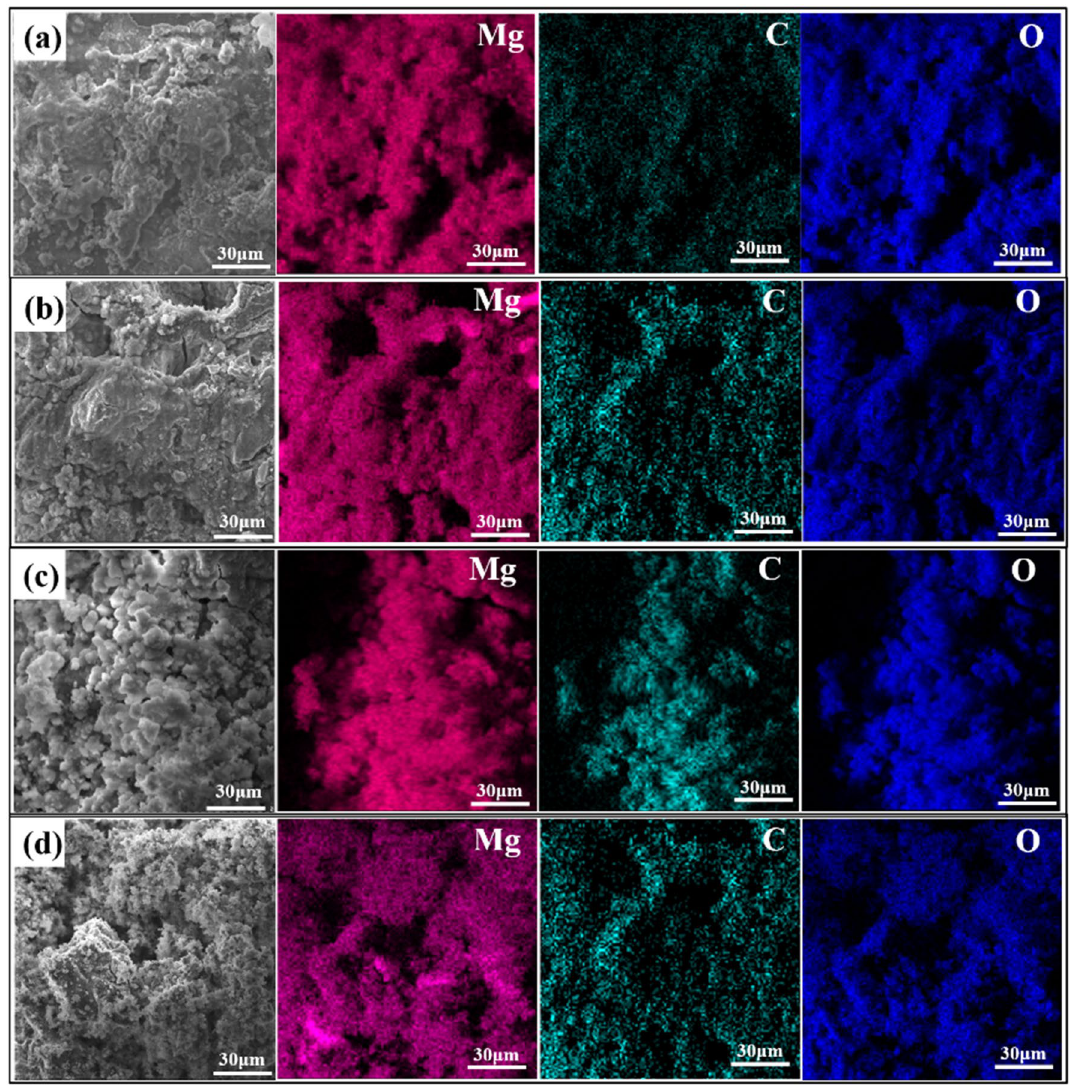
Figure 5. SEM and EDS analysis of AZ91 Mg alloys immersed in 3.5 wt% NaCl solution ( a ) without and with ( b ) 2 g/L GUE ( c ) 2 g/L PDE ( d ) 2 g/L TOE for 24 h under normal atmospheric